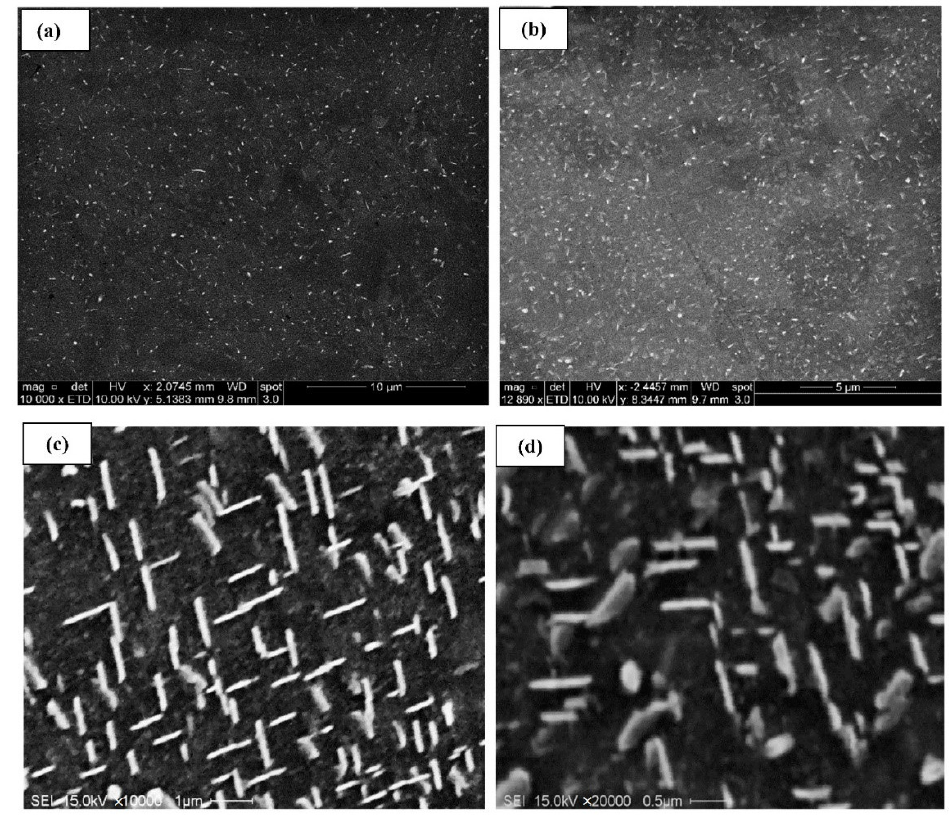
Figure 8. Electron images showing precipitation observed in alloy 220A after aging at ( a ) 180 °C—at 10,000×; ( b ) 220 °C—at 10,000×; ( c ) 300 °C—at 10,000×; and ( d ) 300 °C—at 20,000× magnification.